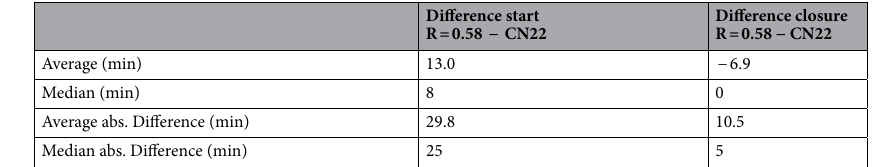
Table 6. Comparison between the times calculated by Calvari and Nunnari, 2022 (CN22 in the table) for the eruptive episodes in 2021 and those we obtained with the threshold R = 0.58 and four or more flagging